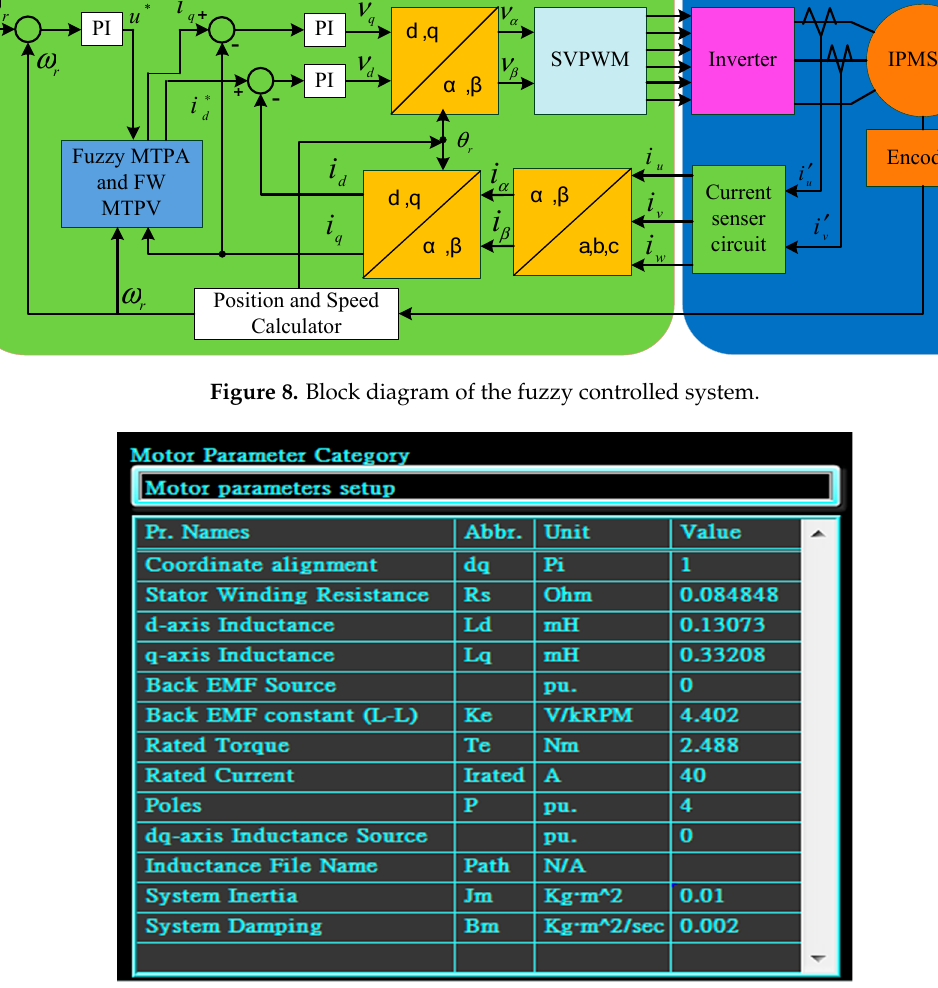
Figure 7. Parameters of IPMSM (taken from HIL).